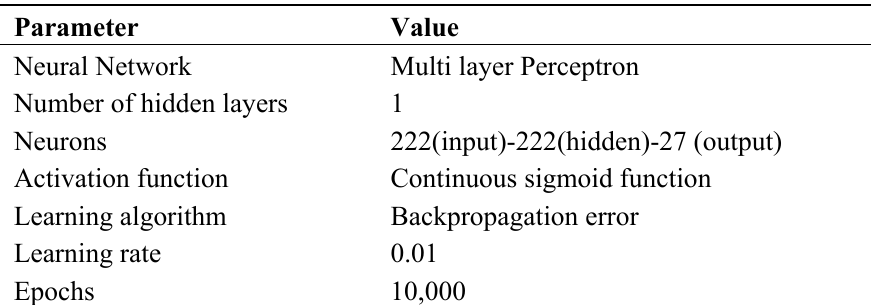
Table 1. Summary of parameters of the neural network.